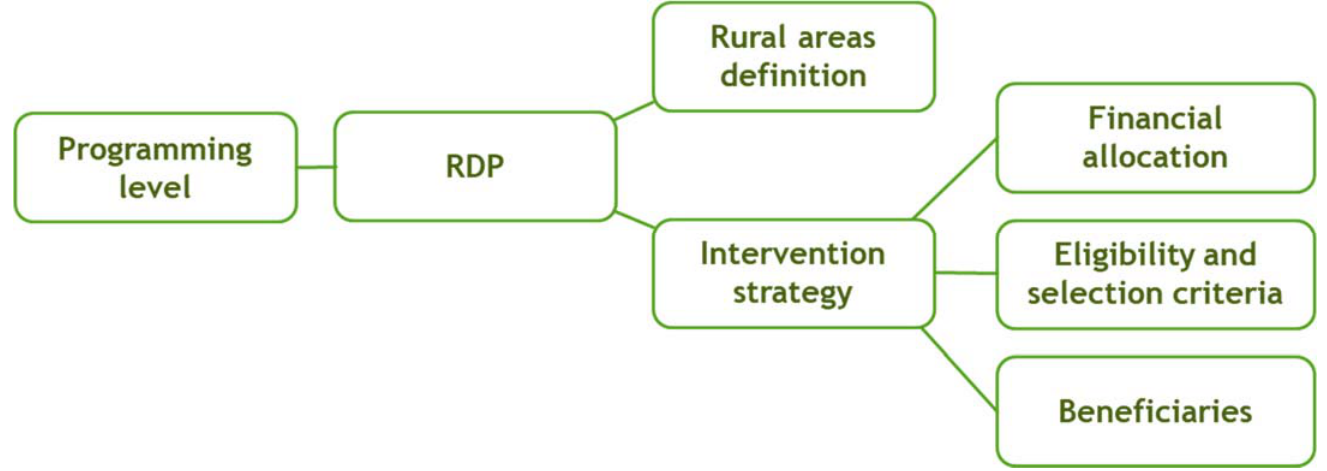
Figure 2. RDP programming level: early general definition of territorial priorities.